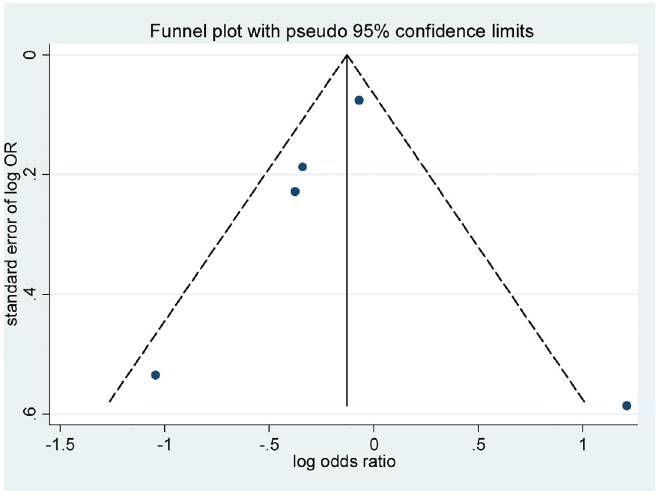
Fig 5. Begg ’ s funnel plot for the analysis of publication bias in studies on the incidence of infection, including all five studies comparing patients exposed and unexposed to statins.